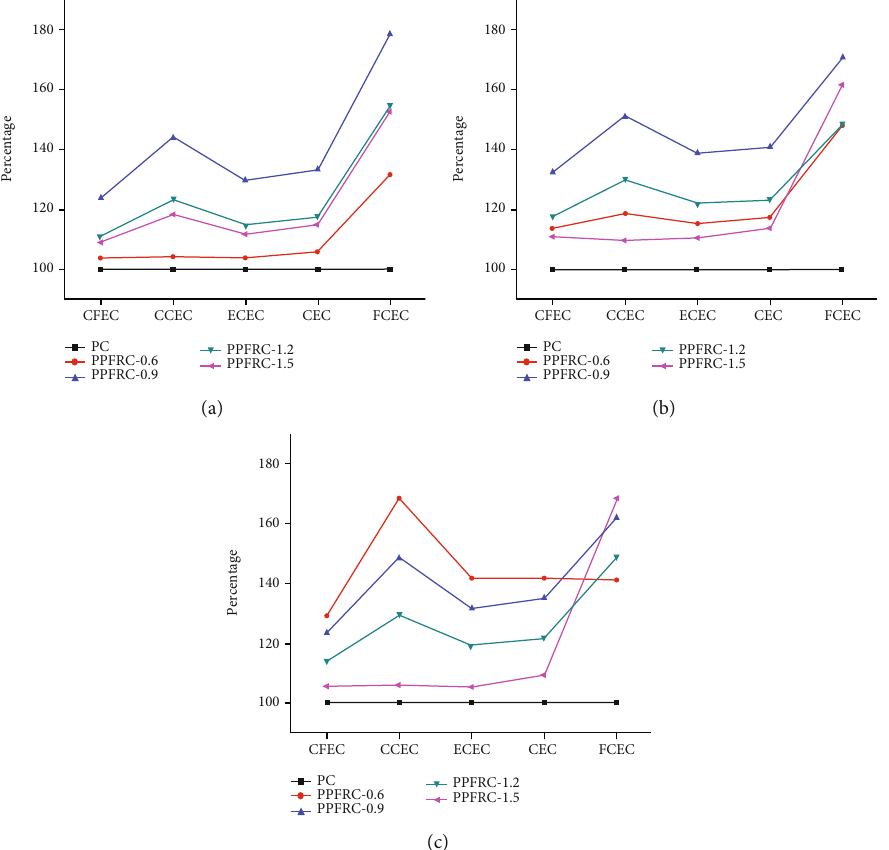
Figure 14: Comparison of PC and PPFRC energy absorption: (a) 14 days, (b) 28 days, and (c) 60